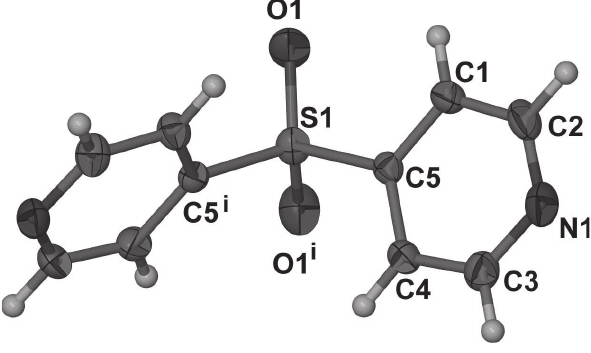
Table 2: Fractional atomic coordinates and isotropic or equivalent isotropic displacement parameters (Å 2